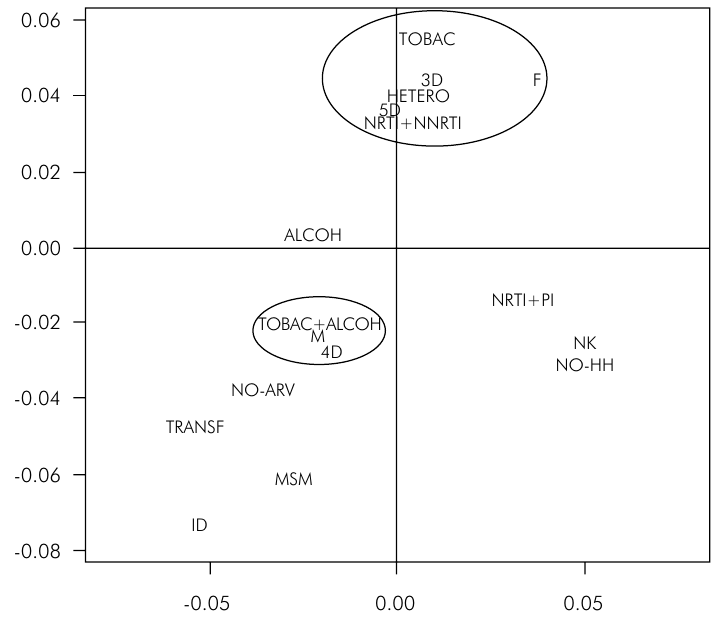
Figure 4. Correspondence analysis, from 2001 to 2005, lists the variables: age, harmful habits, HIV exposure category, gender and ARV.